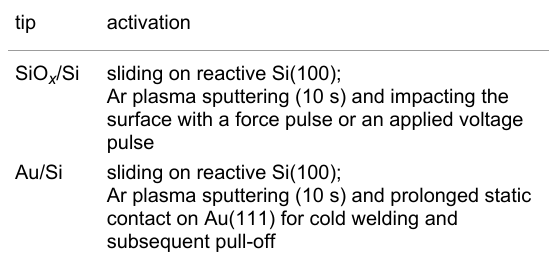
Table 1: Methods for activating the tip apices. The more controlled method is listed first.